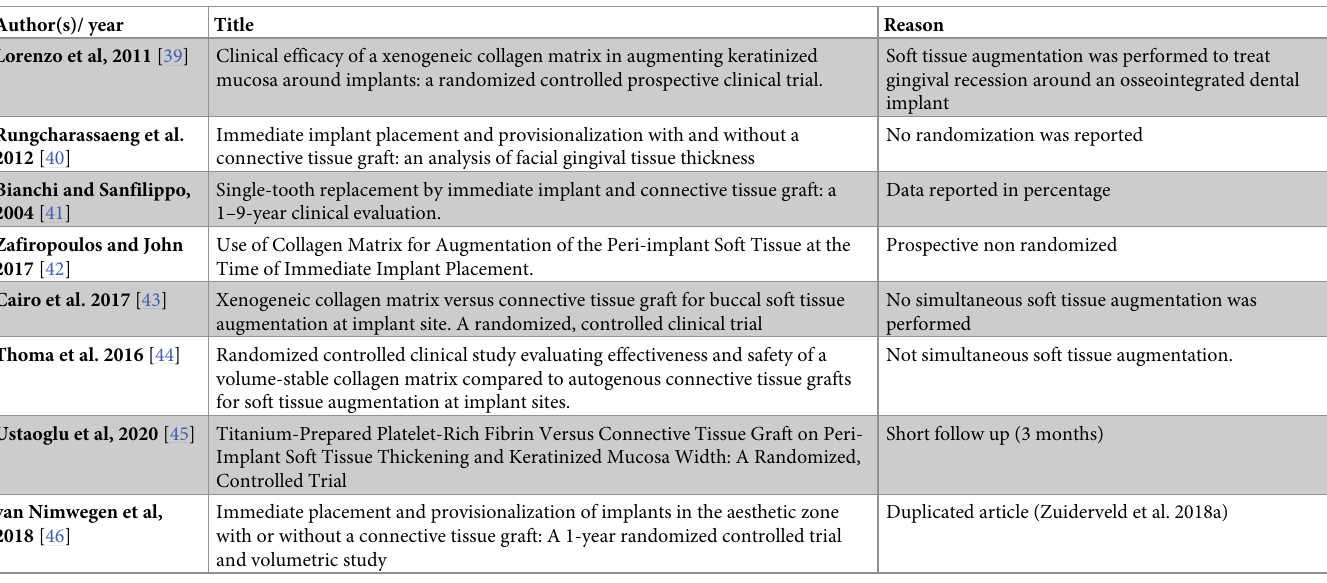
Table 2. Excluded studies and reasons for